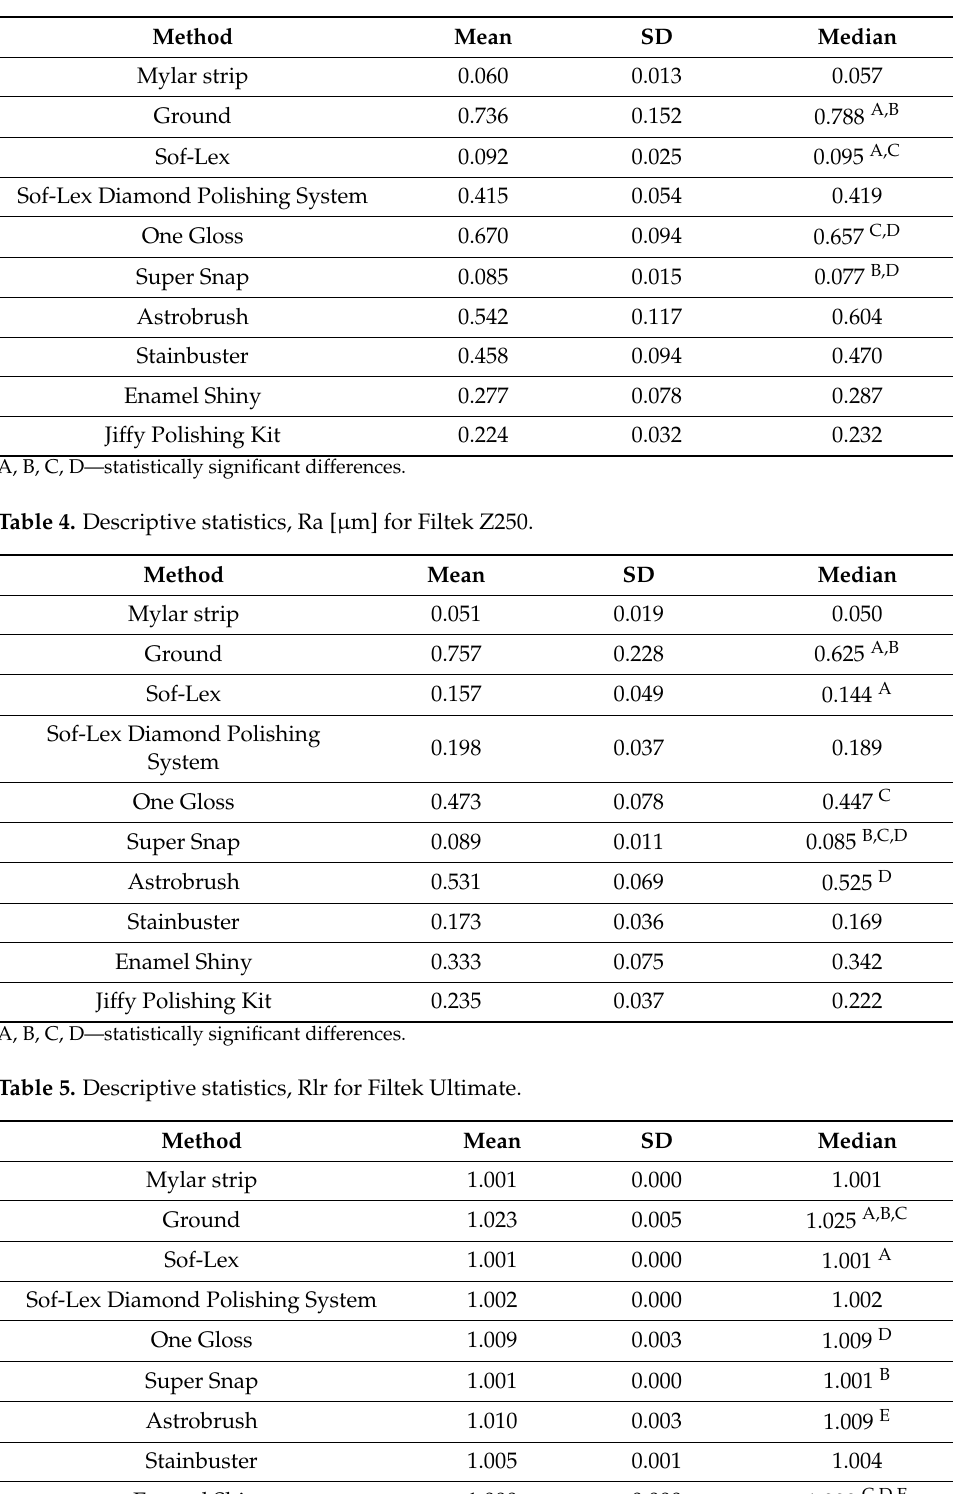
Table 3. Descriptive statistics, Ra [ µ m] for Filtek Ultimate.